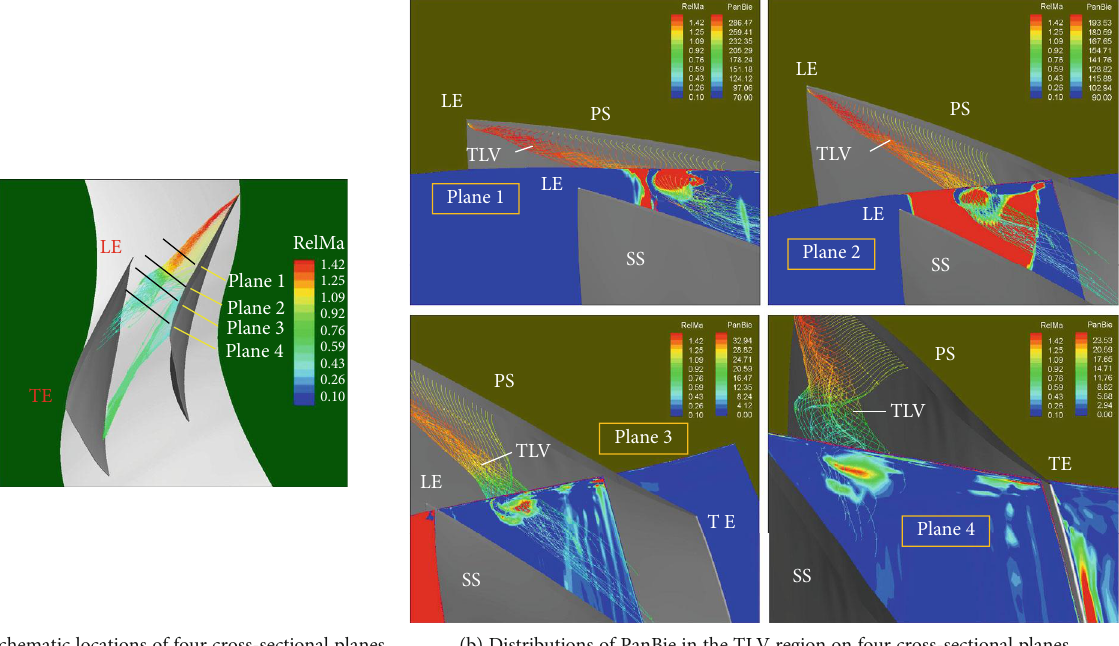
Figure 26: Identi fi cation of TLV existence by parameter PanBie at near-peak e ffi ciency